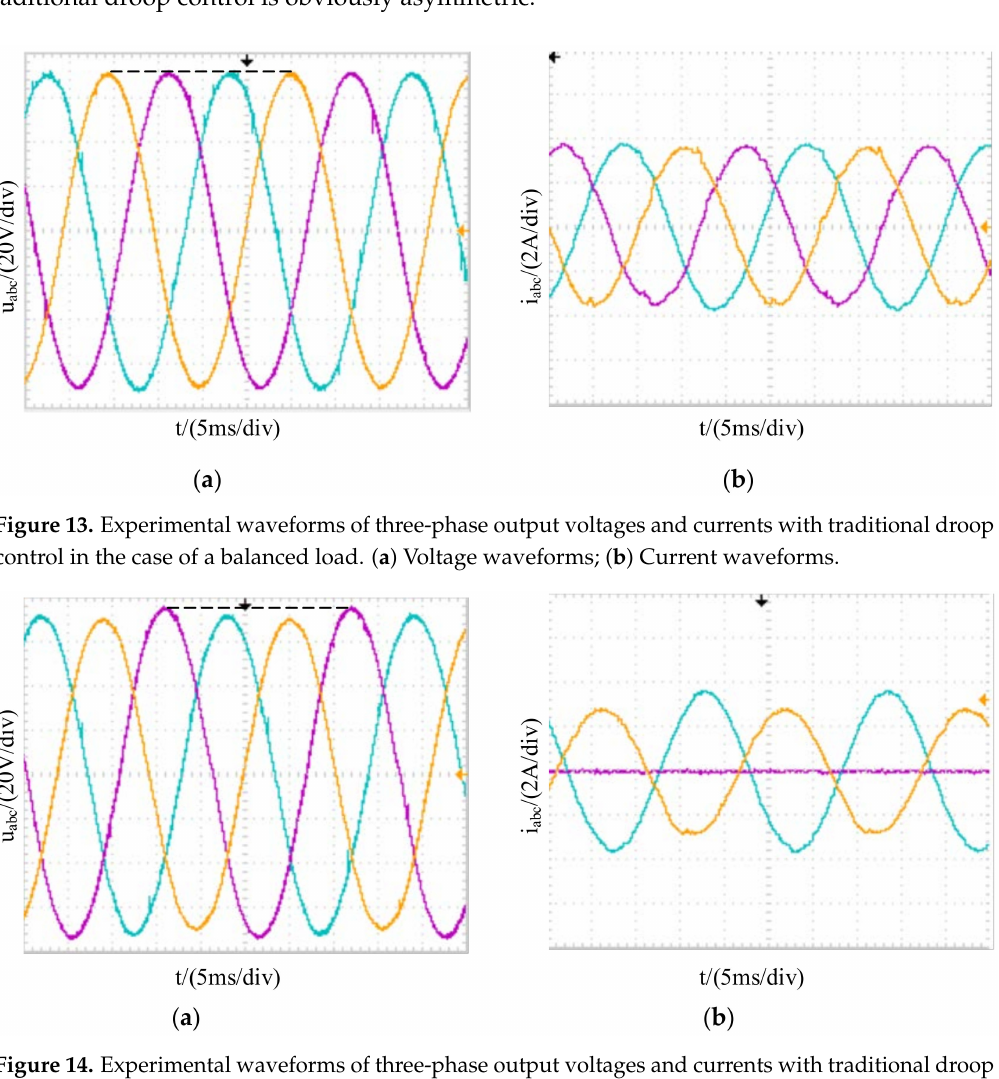
Figure 14. Experimental waveforms of three-phase output voltages and currents with traditional droop control in the case of an unbalanced load. ( a ) Voltage waveforms; ( b ) Current